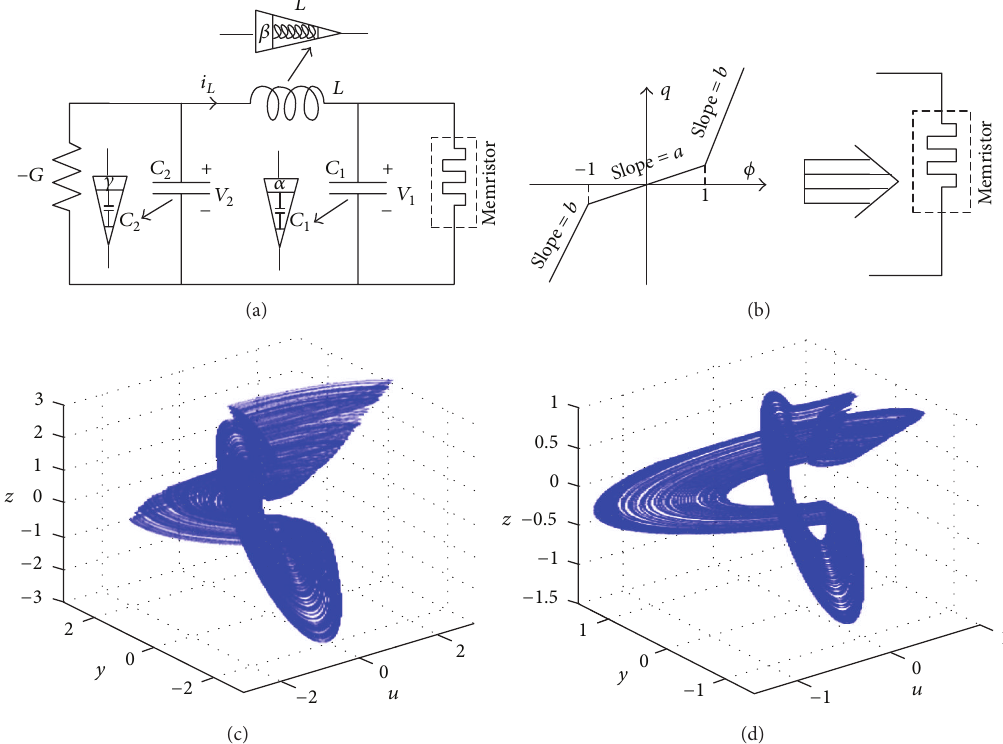
Figure 1: (a) The canonical Chua’s circuit with memristor, (b) the piecewise-linear flux-controlled memristor, and (c) 3D shapes in the u - y - z plane when (𝛼,𝛽,𝛾) (a) (1.0, 0.9, 0.9) and (d) (1.1, 0.9,